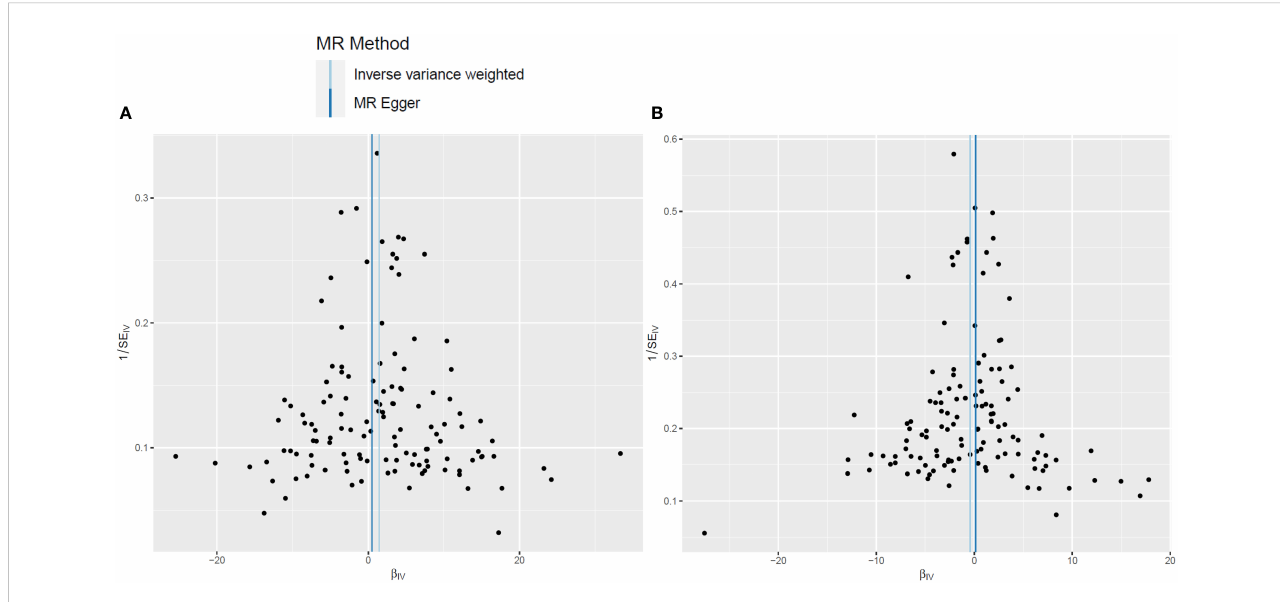
FIGURE 3 Funnel plots of leukocyte telomere length genetic variants and non-scarring alopecia. (A, B) . Funnel plots for androgenetic alopecia (A) and alopecia areata (B)